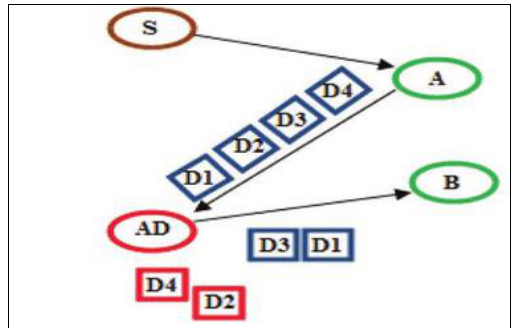
Figure 8: Drops Selected packets of a